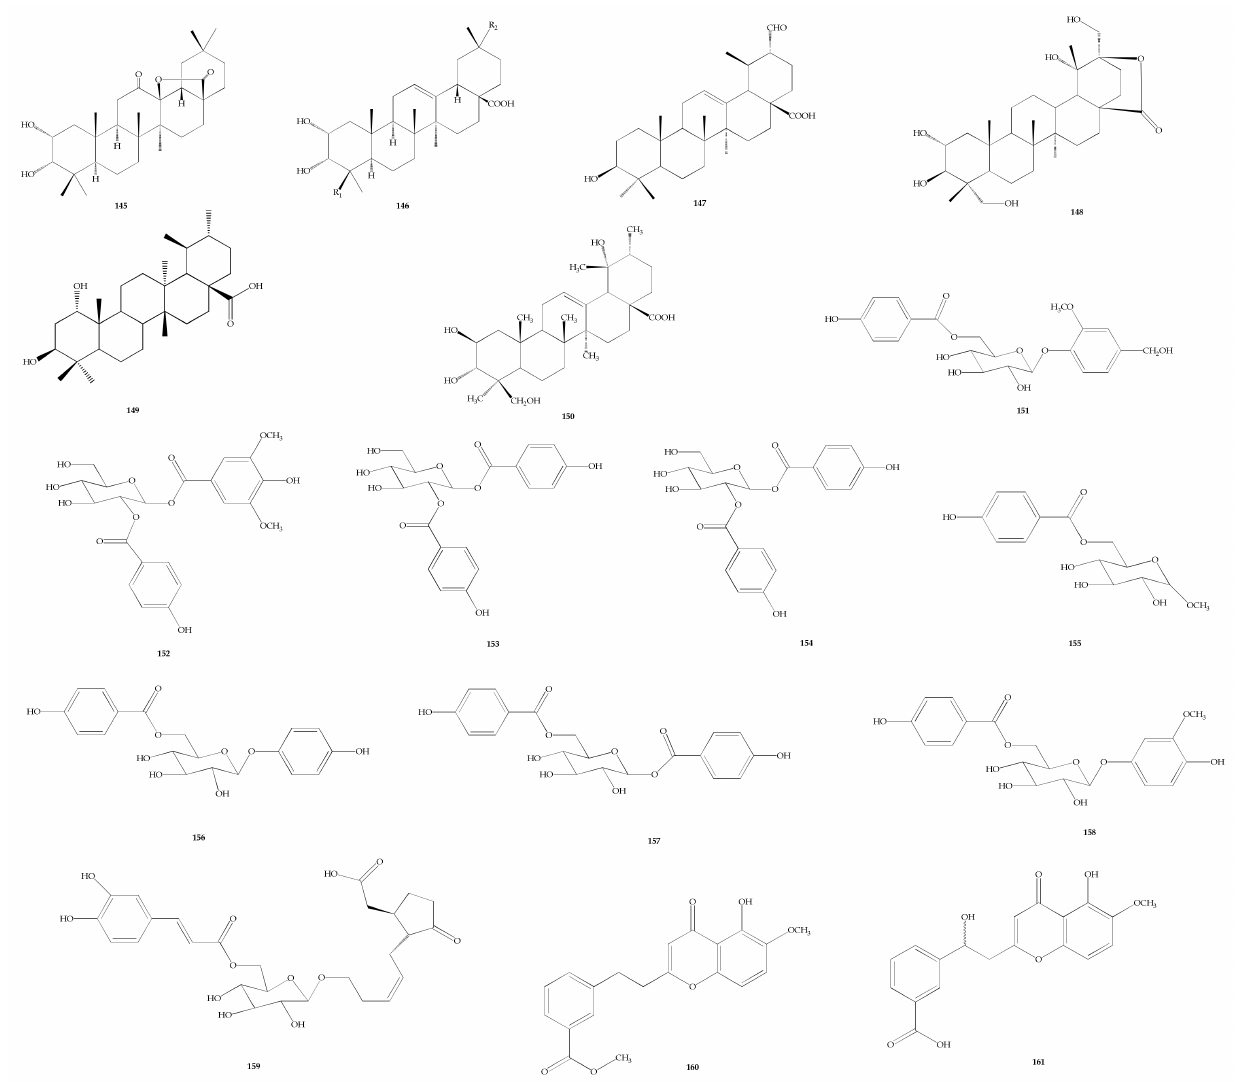
Figure 7. Chemical structures of compounds 128 – 161 found in Vitex